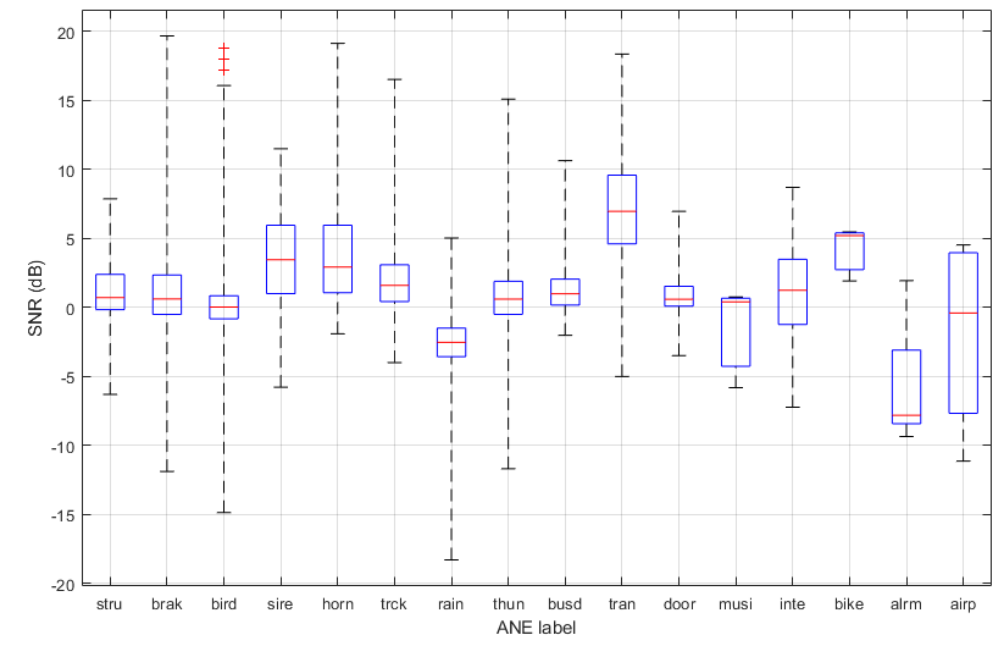
Figure 7. Boxplots of SNR for each ANE